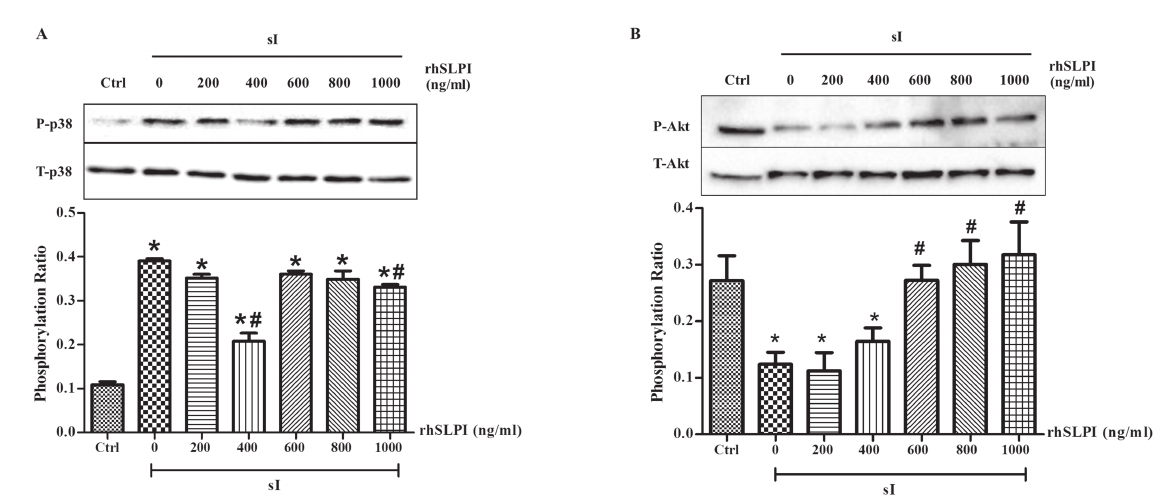
Figure 8: Effects of rhSLPI treatment in H9c2 cells on p38 MAPK and Akt activation during simulated ischemia. A and B show H9c2 cells treated with various concentrations of rhSLPI and stimulated with sI. The cells were then harvested, and p38 MAPK (p-P38) and Akt (p-Akt) activation were determined by Western Blot. Each bar graph represents fold phosphorylation of p38 MAPK and Akt for each of the three experiments. * p < 0.05 vs control of each group (ANOVA). # p < 0.05 vs sI